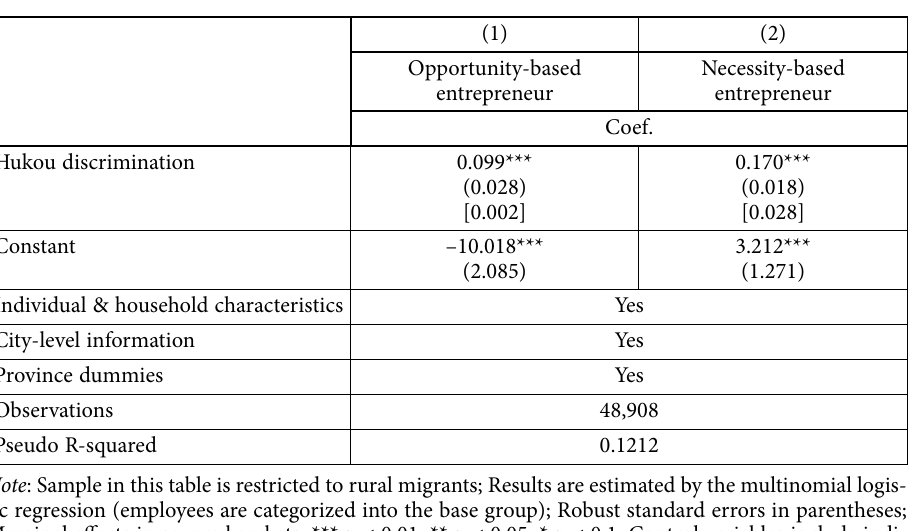
Table 7. Hukou discrimination and entrepreneurship: necessity vs. opportunity-based entrepreneurs (sample of rural